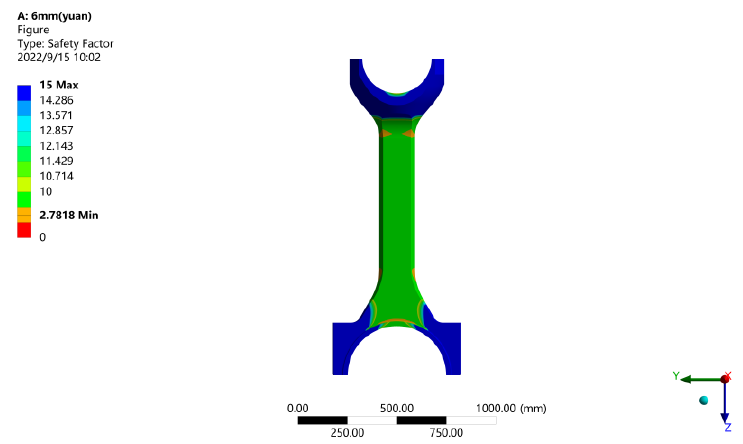
Figure 16. Safety factor diagram of connecting rod body.